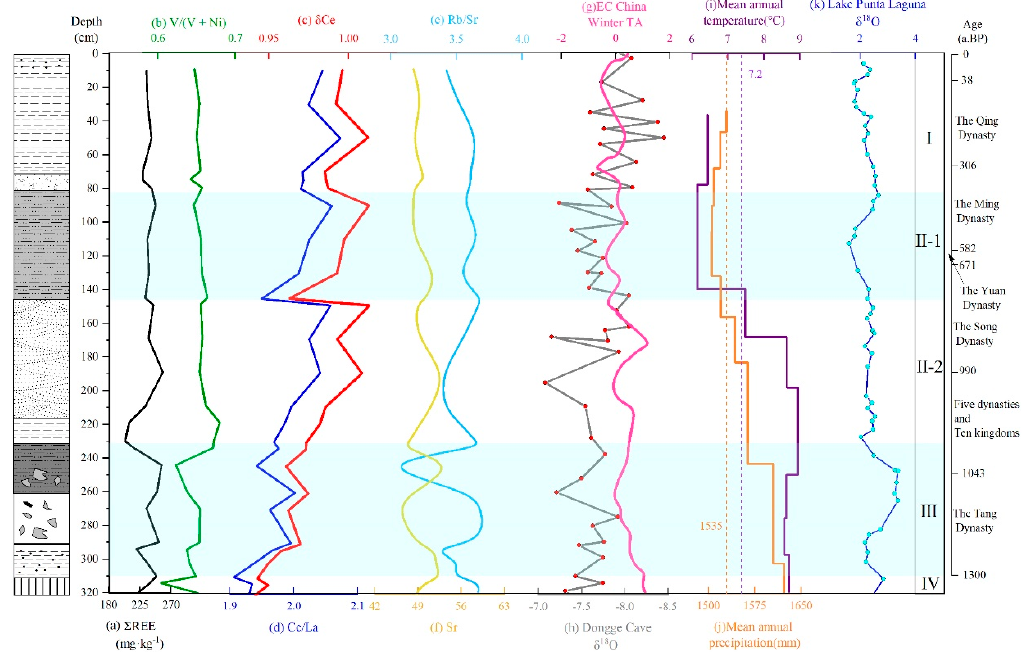
Figure 5. ( a ): Vertical distribution trend of ∑ REEs in the SZP profile. ( b – d ): Variations of paleo − redox environment proxies( δ Ce, Ce/La, V/(V + Ni)). ( e , f ): Characteristics of the paleoclimate proxies (Rb/Sr, Sr, the unit of Sr is mg·kg − 1 ) in the SZP section. ( g ): The winter half − year temperature anomaly (TA) for central − eastern (EC) China, adapted form[81]. ( h ): the δ 18 O values from stalagmites Dongge cave, adapted from [82]. ( i – j ): Temperature and precipitation curves based on sporulation data from Lake Dajiu in Central Yangtze River. Vertical lines represent modern annual temperature (7.2 °C) and precipitation(1535 mm), adapted form [83]. ( k ): Sediment cores from Lake Punta Laguna, northern Yucatan Peninsula, Mexico, adapted form [84]. The blue shaded area represents the high water level period in the Xiangjiang River Basin. Except for 1300 a.BP, the nodes are the extinction time of the dynasty, adapted form [81].